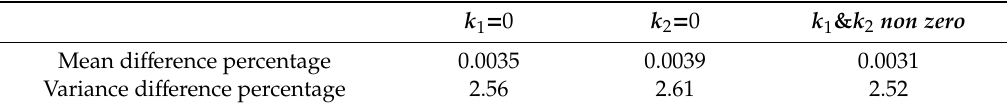
Table 2. PCE vs. MC solution statistics.